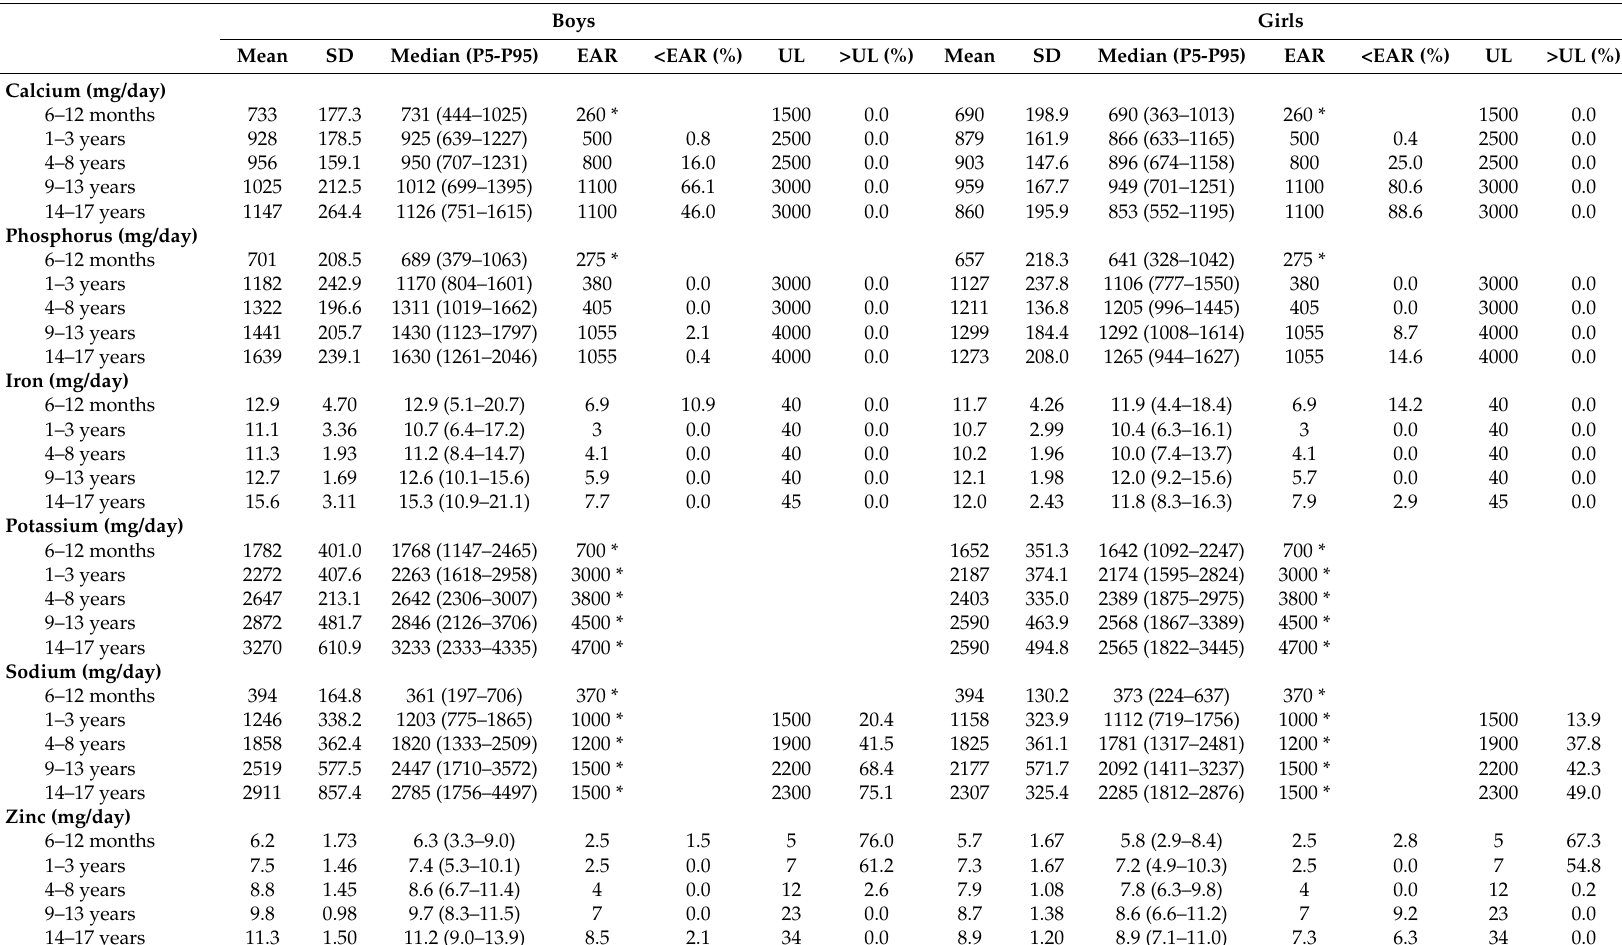
Table 3. Usual intakes of minerals and trace elements (from food and beverage sources only) in Spanish children and adolescents and inadequate